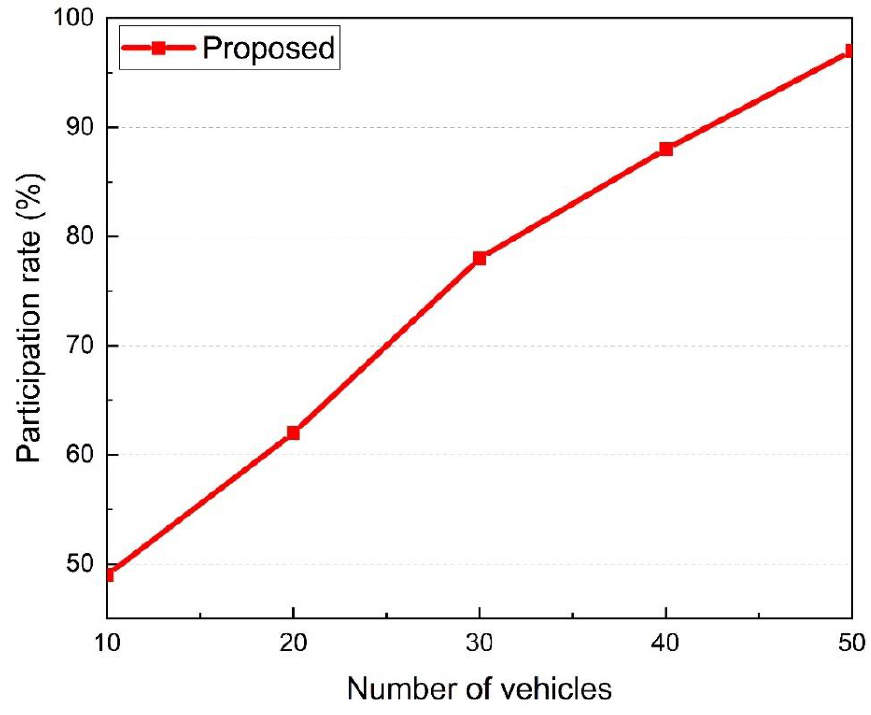
Figure 12. The participation rate.